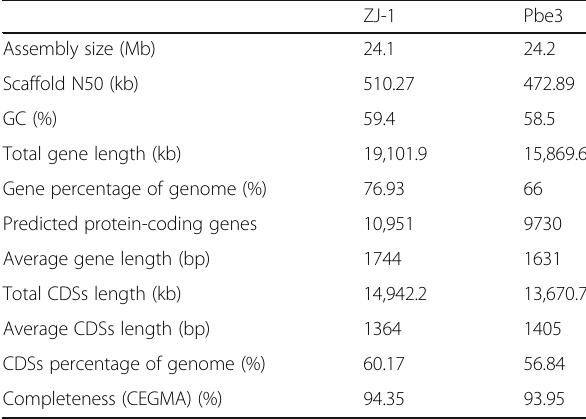
Table 1 Comparison of the genome assembling of Plasmodiophora brassicae strains ZJ-1 and Pbe3